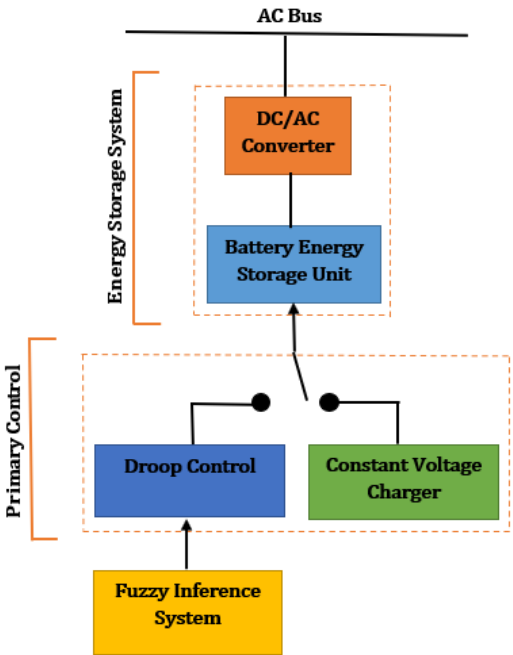
Figure 6. FIS-based fuzzy droop Control.